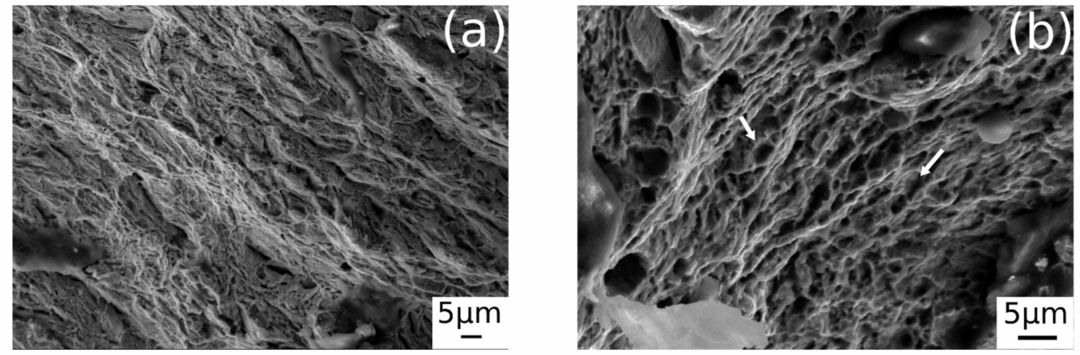
Figure 16. ( a ) SEM fractography of the sample in annealed condition ( b ) fractography showing dimples (indicated by white arrrows).